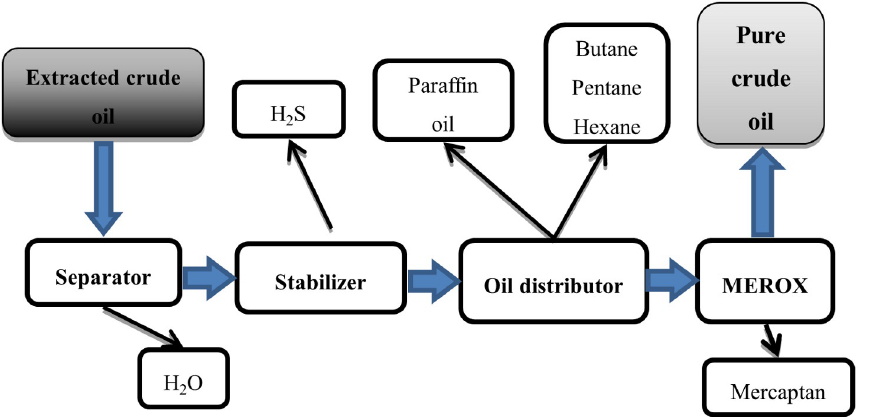
Fig 1. A simplified scheme of the process of crude oil